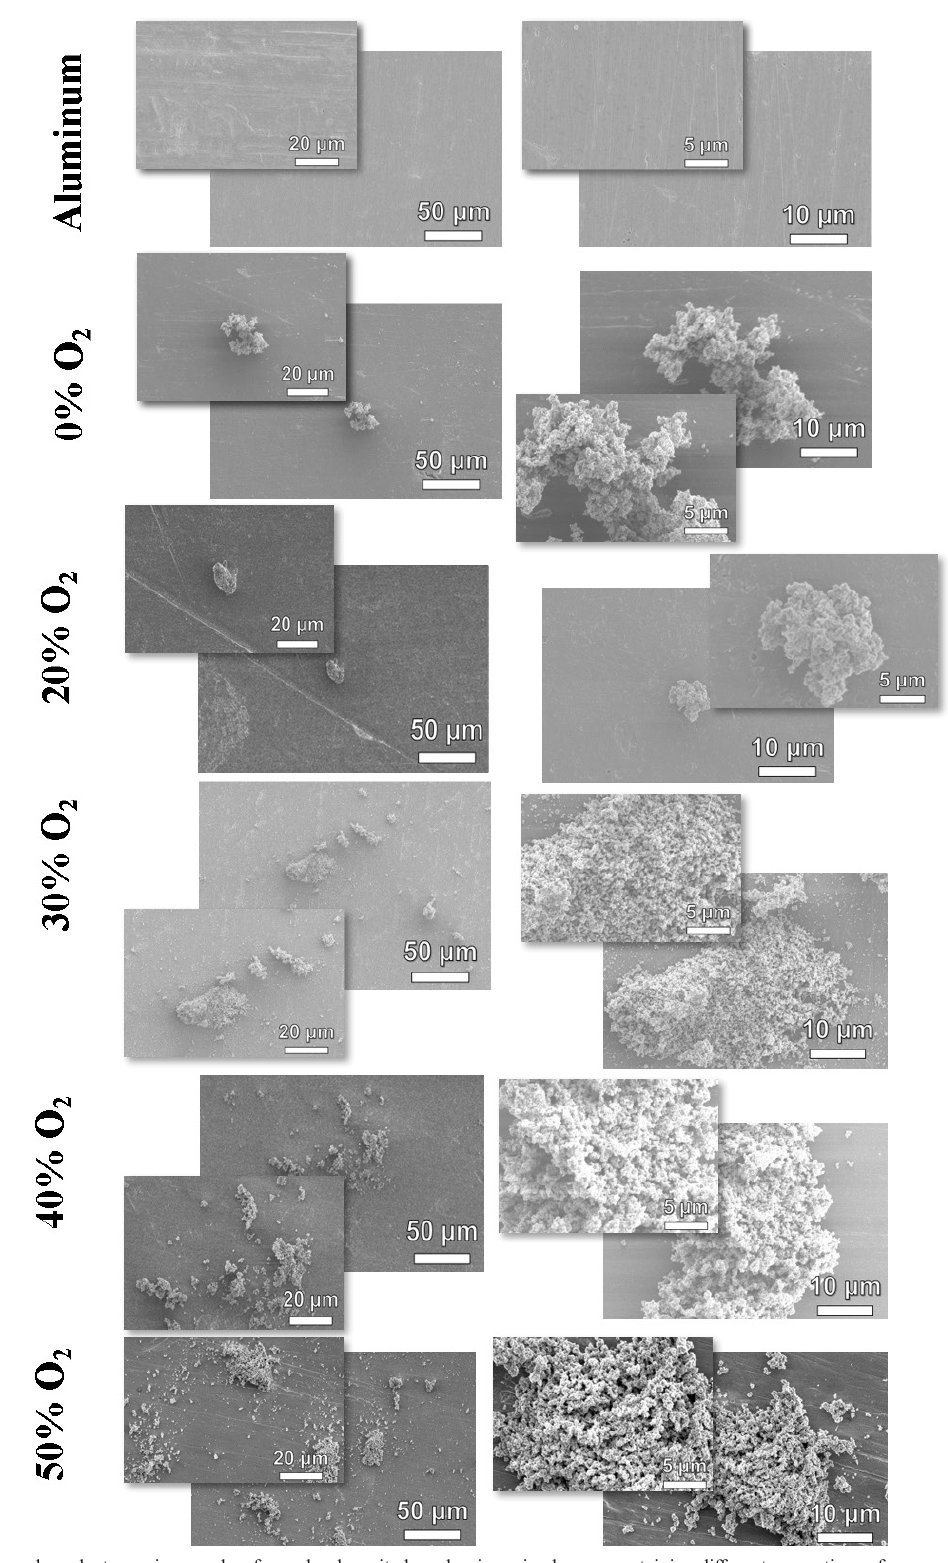
Figure 4. Secondary electron micrographs of samples deposited on aluminum in plasmas containing different proportions of oxygen. The micrograph of the Al substrate is also